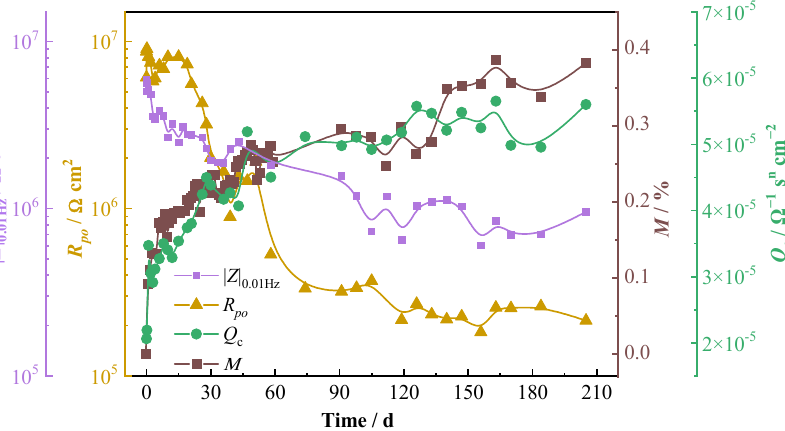
Figure 4. Variations of the percentage mass change, resin capacitance and resistance, and low-frequency impedance of T700/VE specimen with time.